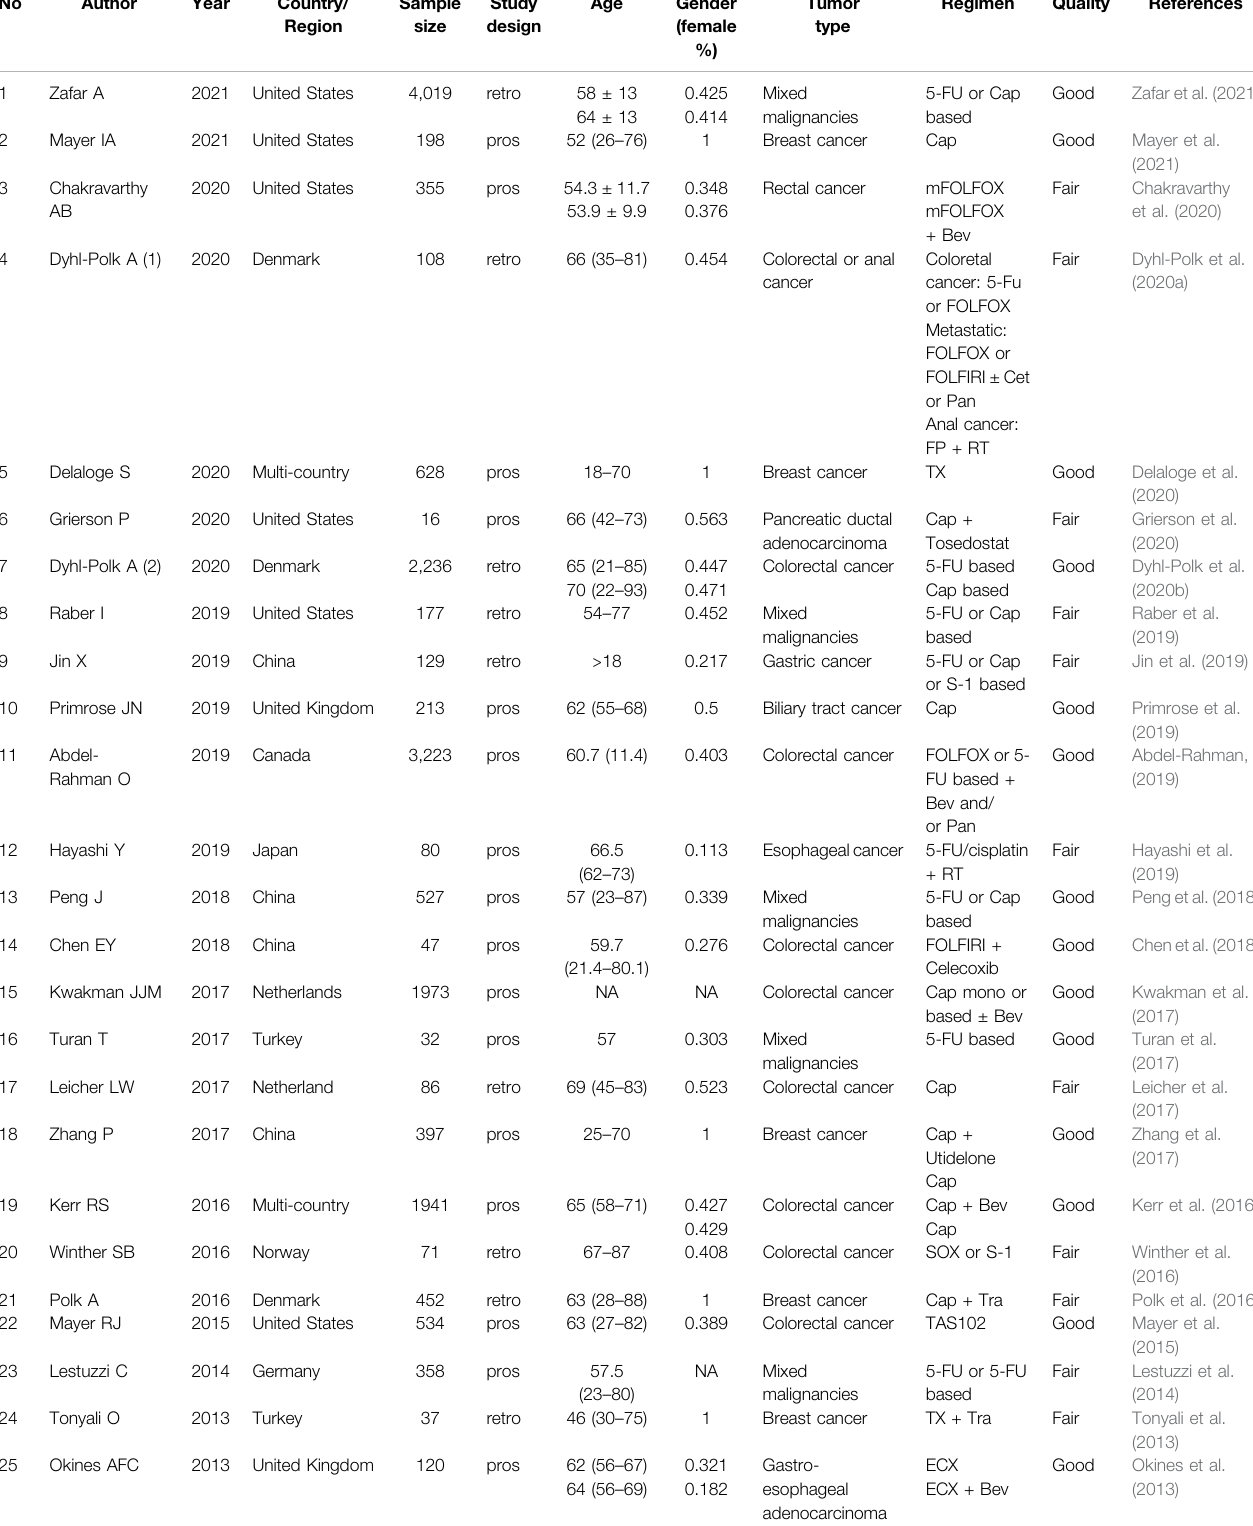
TABLE 1 | The characteristics of the included 64